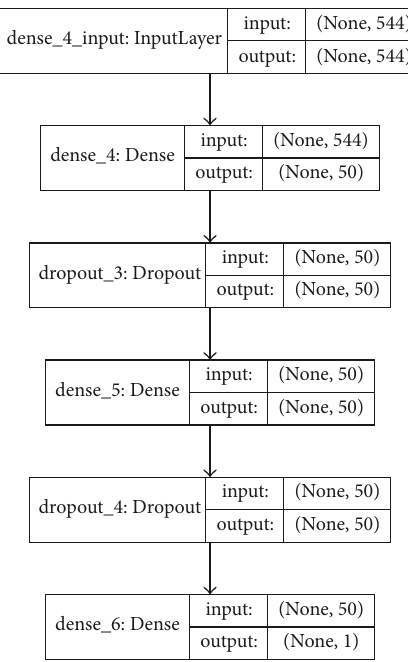
Figure 2: 50x2 mlp elu model. 2 Hidden layer MLP with dropout layer following each hidden